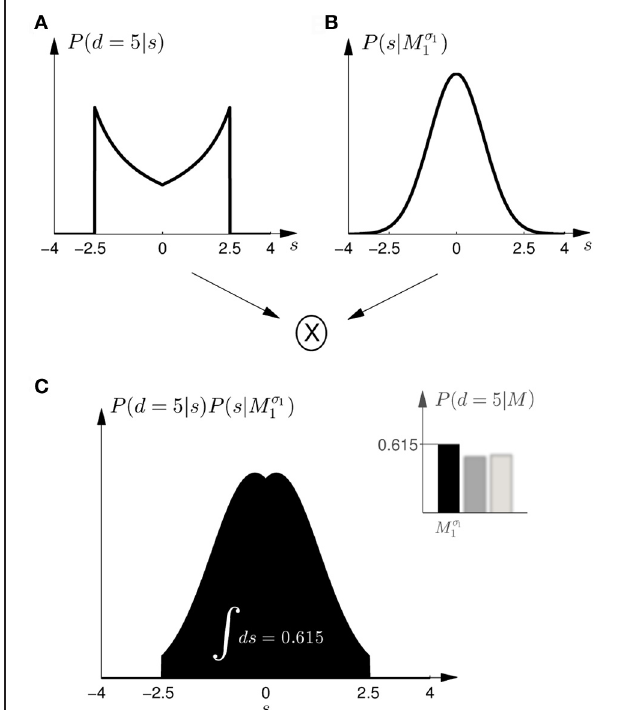
FIGURE 5 | Computation of the model evidence P ( d | M ) when observing an ambiguous cursor array of width d —shown for model M σ 1 1 and d = 5, so the possible shifts of the hand position range from − 2.5 to 2.5cm. (A) Shows the likelihood P ( d = 5 | s ) of observing the ambiguous cursor array of width d = 5 for different shifts s . (B) Shows the prior P ( s | M σ 1 1 ) over the shift s according to model M σ 1 1 . (C) Depicts the product of the distributions in panels (A,B) and illustrates the integration over the shifts s . This computation leads to a single value for the model